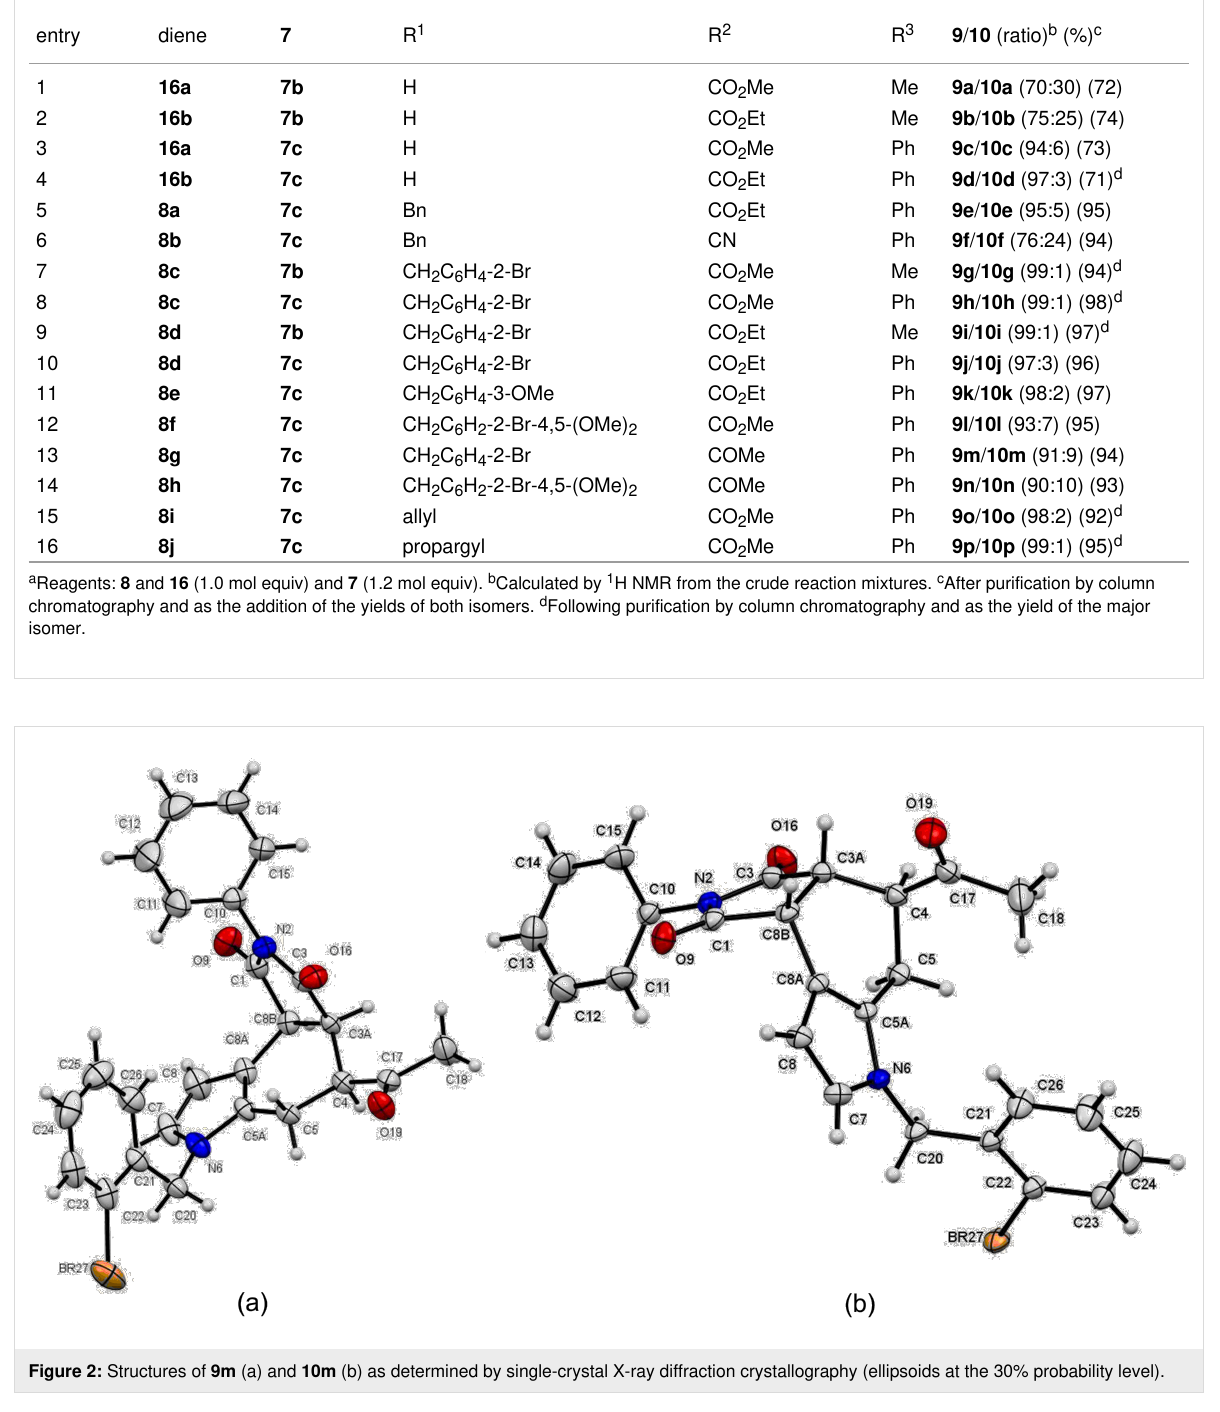
N- substituted 2-acrylonitrile pyrrole 8b . Accordingly, the R 2 substituent in the diene would play an important role in directing the endo/exo orientation of the approach to the male- imide at the transition state (TS). Therefore, the endo diastereo- selectivity is apparently not controlled by the presence or the